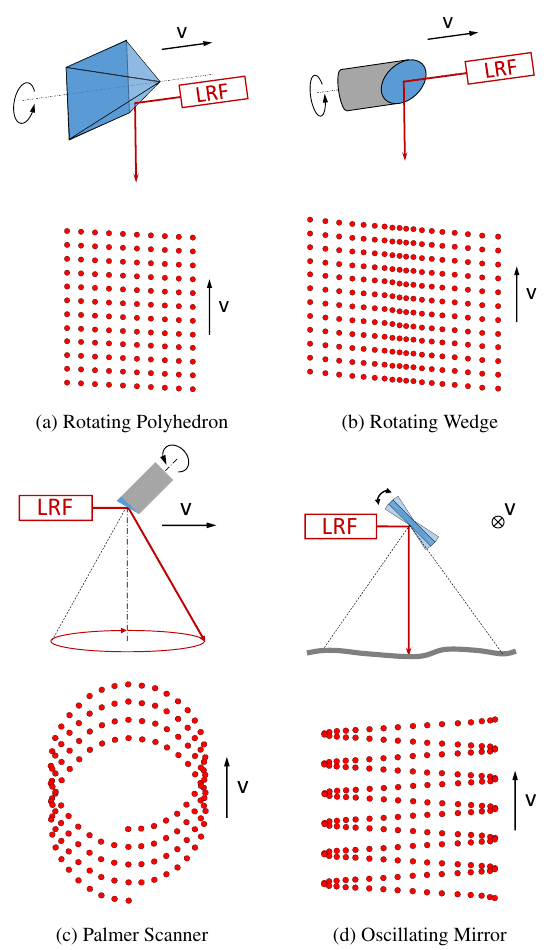
Figure 1. Most common scan mechanics and their scan pattern on a horizontal planar surface; v indicating the direction of motion, LRF is the Laser Rang Finder element